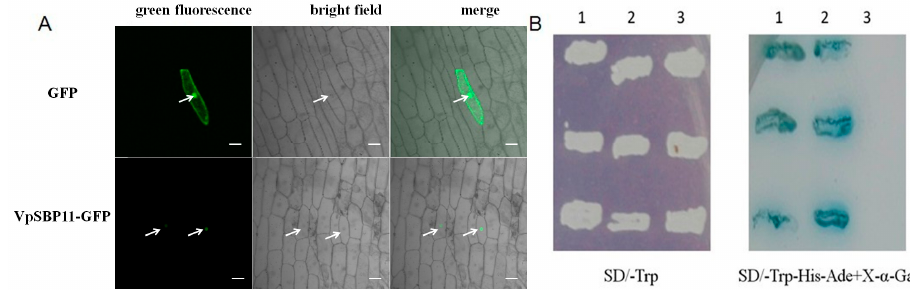
Figure 2. Subcellular localization and transcriptional activation function of VpSBP11 protein. ( A ) Subcellular localization of the VpSBP11-GFP (bottom row) fusion protein and GFP (top row) in onion epidermal cells. Green fluorescence of VpSBP11-GFP occurs only in the nucleus obviously while that of GFP occurs in both the nucleus and cell membrane. White arrowheads indicate the location of the nucleus in onion epidermal cell, scale bars: 50 µ m; ( B ) Transcriptional activation function of VpSBP11 in yeast. Yeast cells containing the different plasmids grown on SD/-Trp select medium (left). Yeast cells containing the different plasmids grown on SD/-Trp-His-Ade+X- α -gal selection medium (right). 1: Positive control (pGBKT7-Gal4); 2: pGBKT7-VpSBP11; 3: Negative control (pGBKT7). The experiments were repeated three times with consistent results. GFP = green fluorescent protein.